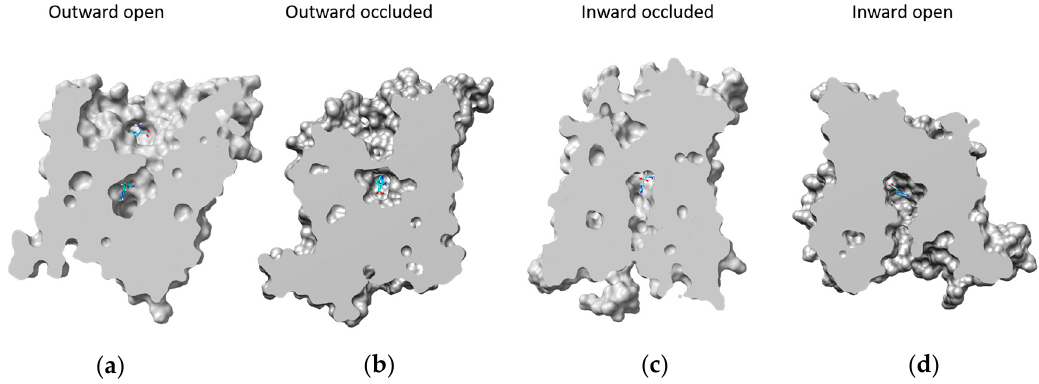
Figure 4. Surface analysis of LAT1 structures. Images show the surface of the transporter in the four different conformations ( a – d ). Structure surfaces were “cut” perpendicularly to the lateral view of the structures, by controlling the near clipping planes of the Side View Tool from UCSF Chimera [27]. The extracellular side corresponds to the upper part of the transporter structures.